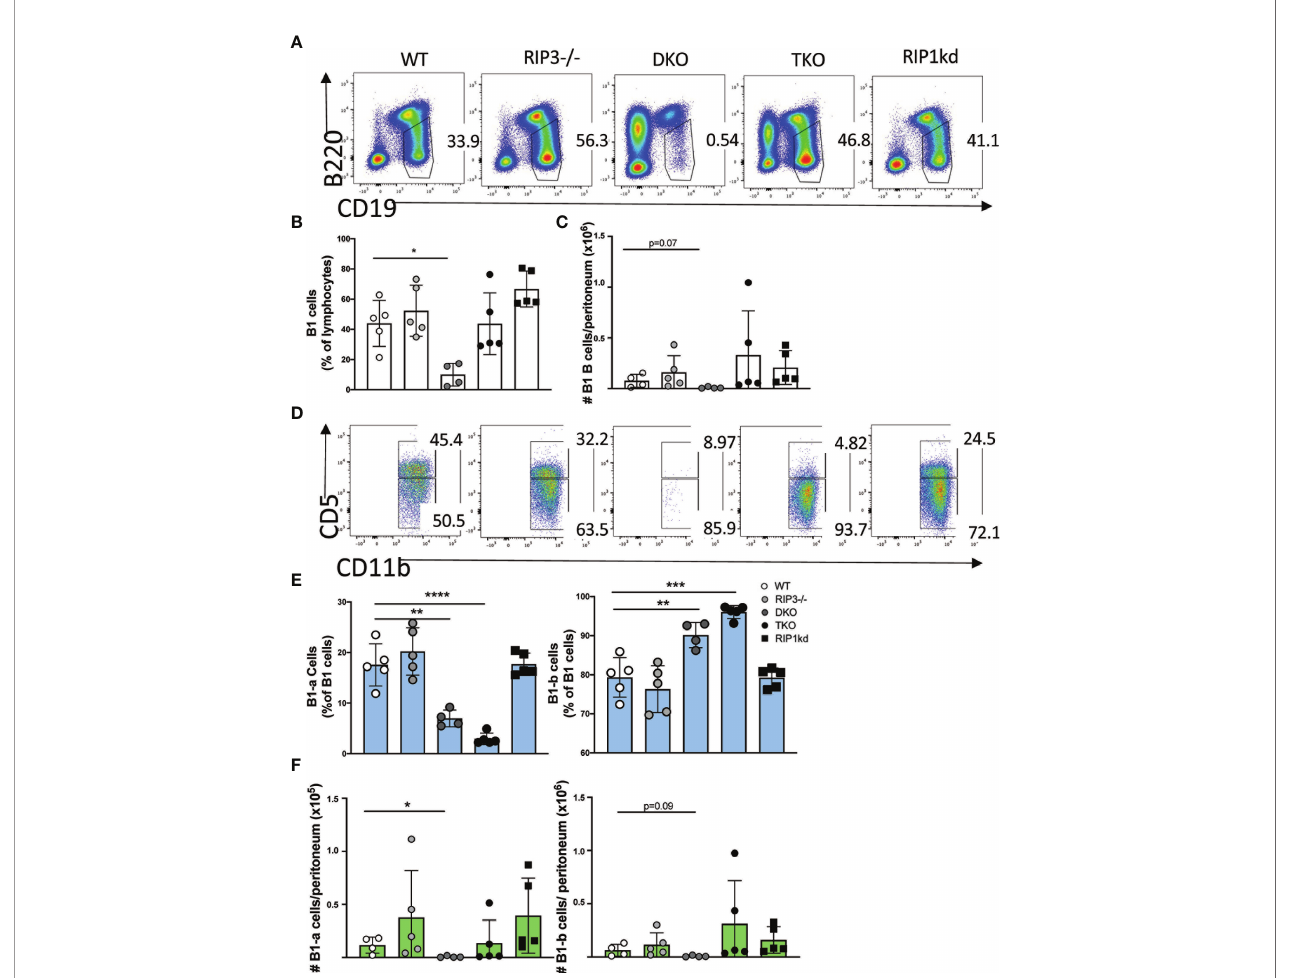
FIGURE 1 | RIP1 and caspase-8 are required for innate B-1 B cell homeostasis. Flow cytometry of C57BL/6 WT, RIP3-/-, DKO, TKO and RIP1 kd murine peritoneal washout cells identi fi es CD19 + B220 lo B1 B cells as percent of live lymphocytes (A) . Scatterplot quanti fi es frequency (B) and number (C) of peritoneal total CD19 + B220 lo B-1 cells. From the CD19 + B220 lo population, CD11b + IgM + B-1 cells (gate not shown) were subgated to identify B1-a (CD5 + ) or B1-b (CD5 - ) subsets (D) . Scatterplots quantify frequency (E) and number (F) of peritoneal B1-a (left) and B1-b (right) cells. Data is representative (A, D) or a pool (B, C, E, F) of two independent experiments with 2-3 mice per group, 8-14 weeks old. Each symbol indicates an individual mouse. *p ≤ 0.05, **p ≤ 0.01, ***p ≤ 0.001, ****p ≤ 0.0001 (One-way